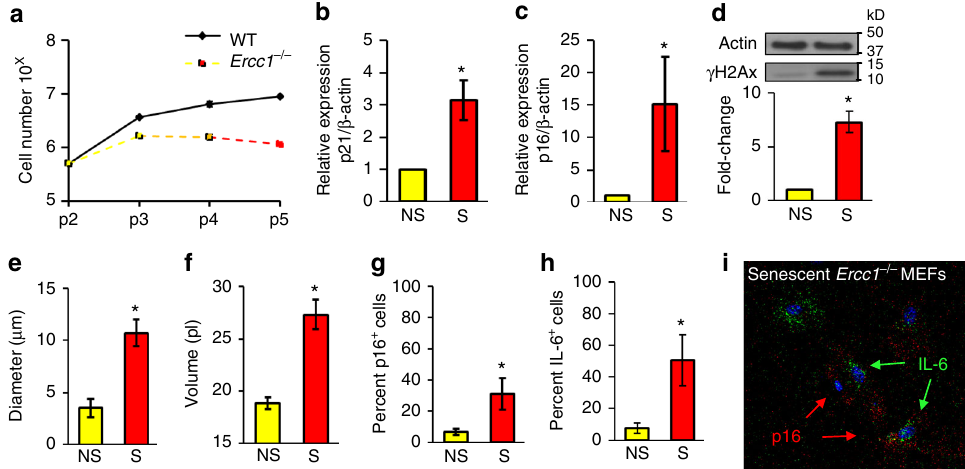
Fig. 2 Detection of senescence markers in Ercc1 − / − MEFs. a Cell proliferation was measured in congenic WT and Ercc1 − / − MEFs from p2 through p5. n = 2. b Relative expression of p21 Cip1 and c p16 INK4a in p2 non-senescent (NS) and p5 senescent (S) Ercc1 − / − MEFs determined by qRT-PCR. Error bars indicate SD for n = 3. * p < 0.05, two-tailed Student ’ s t -test. d Protein expression levels of γ H2AX in p2 NS and p5 S Ercc1 − / − MEFs. Changes in diameter e and volume f in p2 NS and p5 S Ercc1 − / − MEFs. Error bars indicate SD for n = 3. * p < 0.05, two-tailed Student ’ s t -test. Ratio of cells expressing p16 INK4a g and IL- 6 h in p2 NS and p5 S cultures determined by ViewRNA fl uorescence in situ hybridization. Error bars indicate SD for n ⩾ = 2. * p < 0.05, two-tailed Student ’ s t -test. i Representative FISH image of p16 INK4a and IL-6 of passage 5 S Ercc1 − / − MEFs